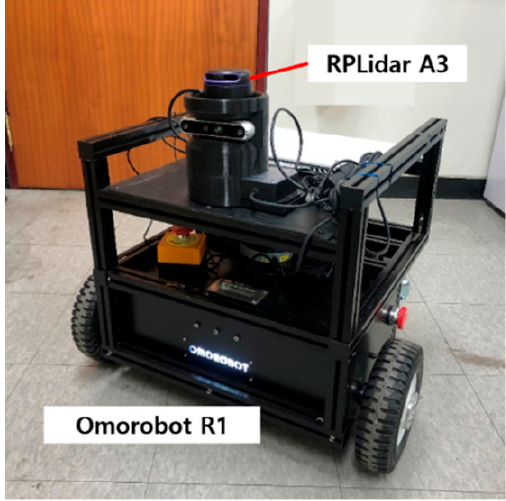
Figure 12. Robot and sensor used for experiments.